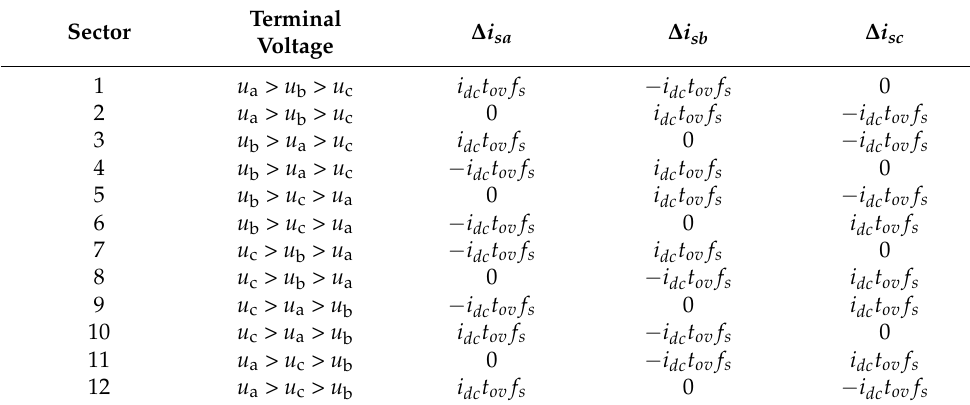
Table 2. Effect of overlap time with the non-nearest three vector.